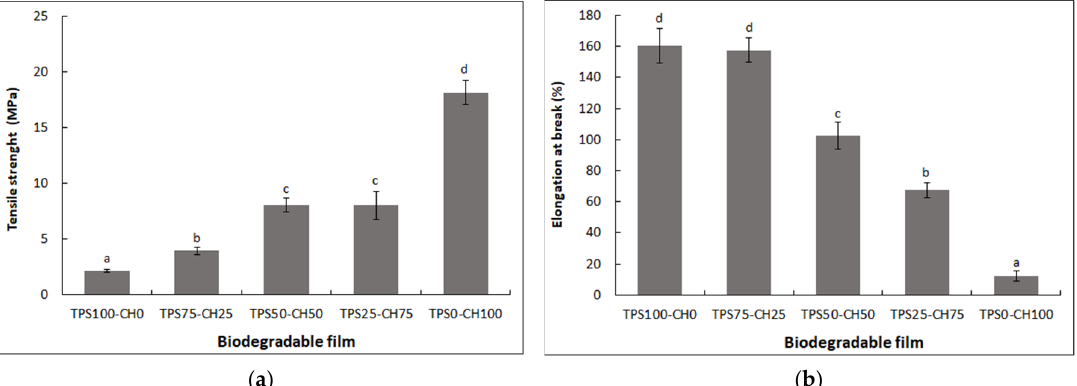
Figure 6. Mechanical properties of starch:chitosan biodegradable films. ( a ) Tensile strength; ( b ) elongation at break expressed as percentage. Values with a different denote significant difference (Tukey test; p < 0.05). Mean values ( n = 3) and standard deviation.